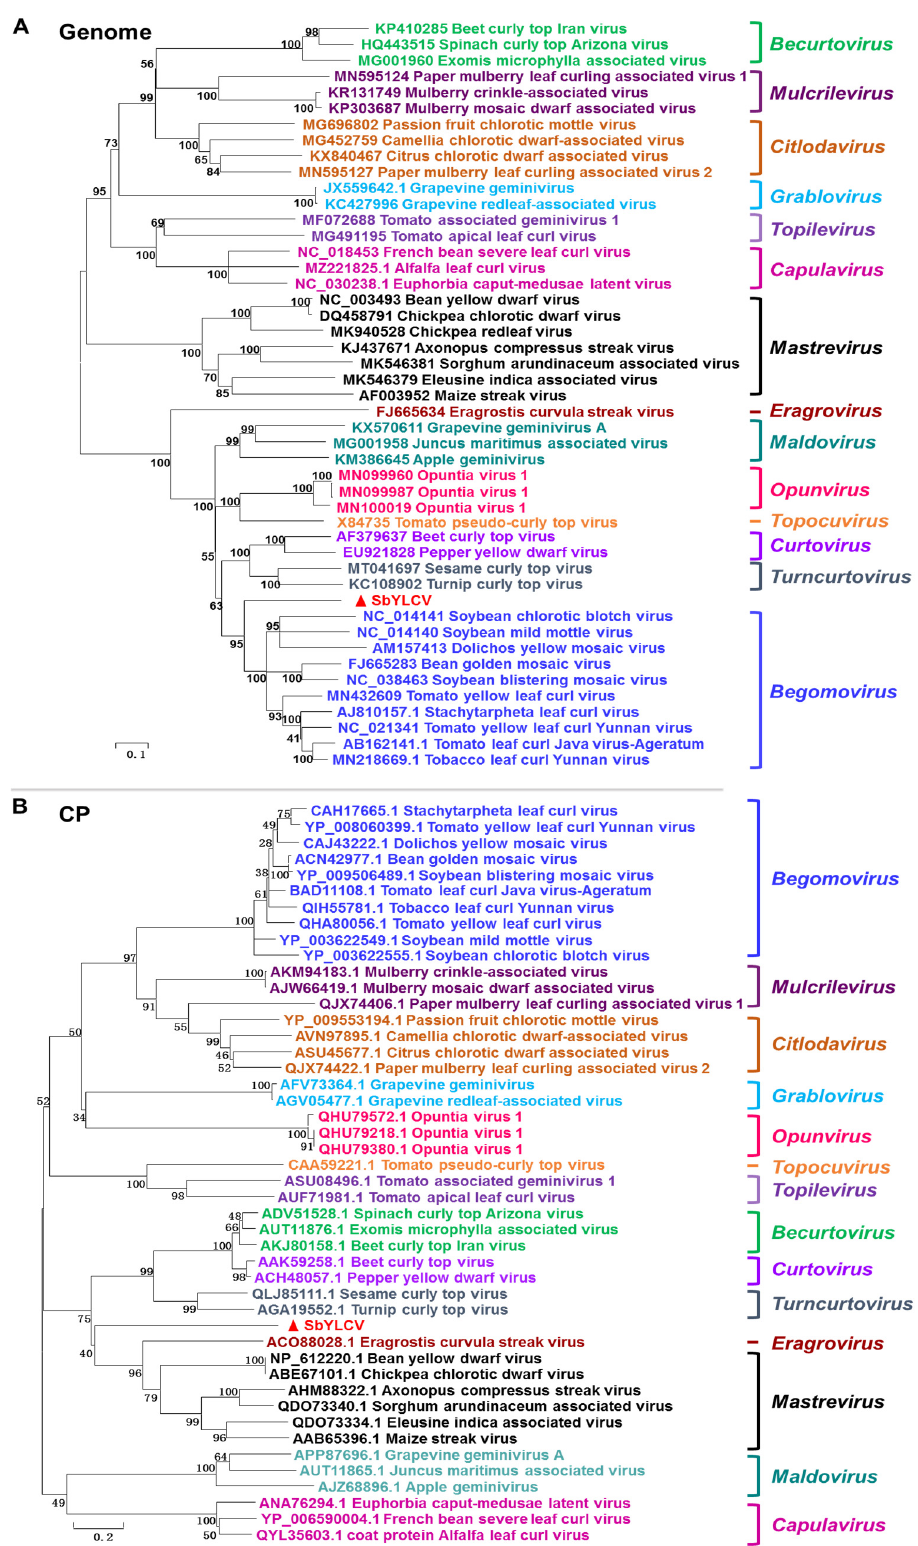
Figure 3. Phylogenetic relationships of SbYLCV and representative geminiviruses based on the nucleotide sequence of the full-length genome ( A ) and the amino acid sequence of the coat protein (CP) ( B ). The phylogenetic trees were constructed with MEGA 5.0 using the neighbor-joining method. The statistical significance of the branches was determined with a bootstrap of 1000 replicates.